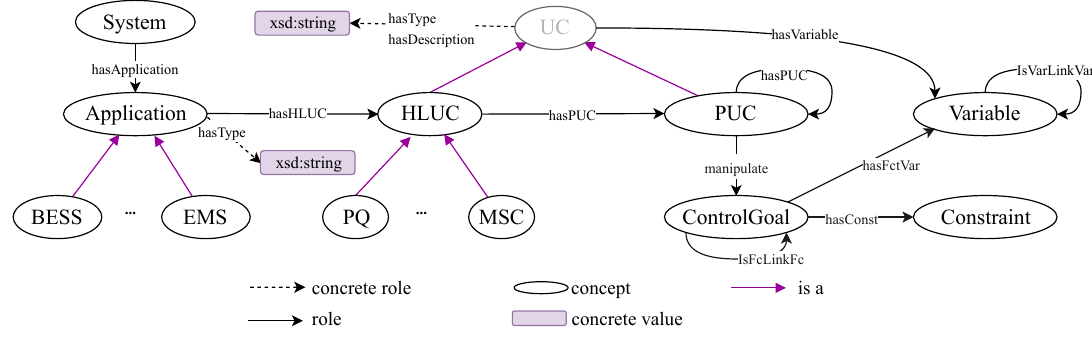
Figure 4. Graph representation of EMS structure.